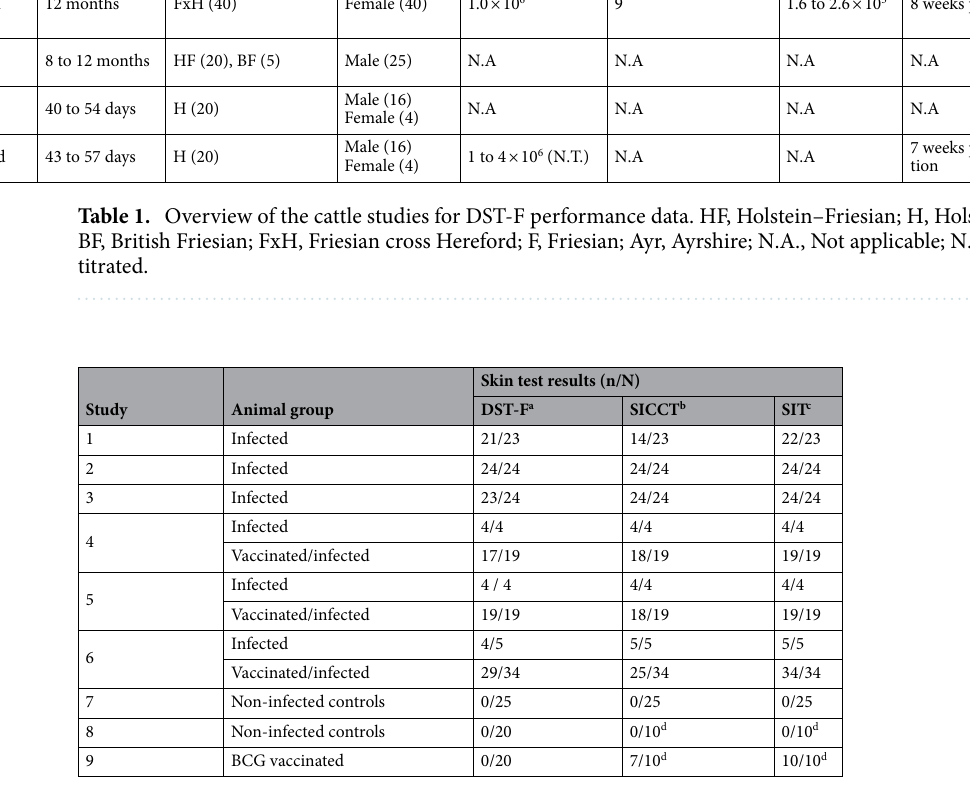
Table 2. Skin test performance data for the DST-F reagent. n , number positive; N , total number tested. a Response considered positive if Δ skin thickness for DST-F ≥ 2 mm. b Response considered positive if Δ